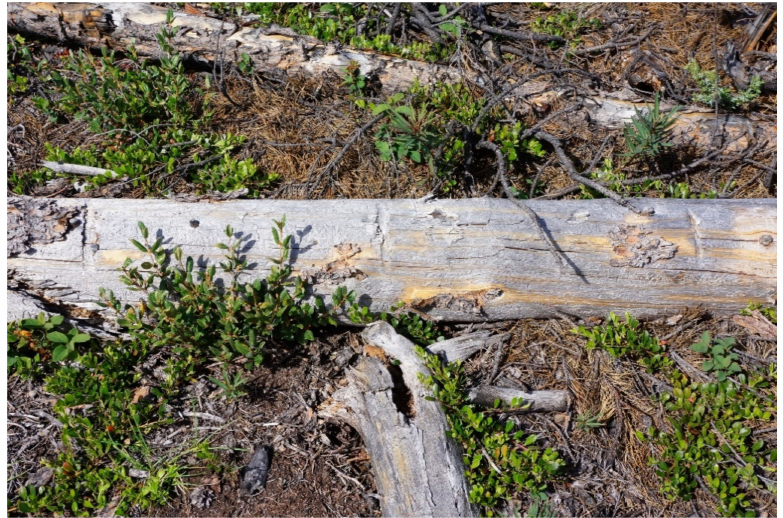
Figure 5. Postharvest material pressed into the ground with a roller–chopper mechanical treatment.